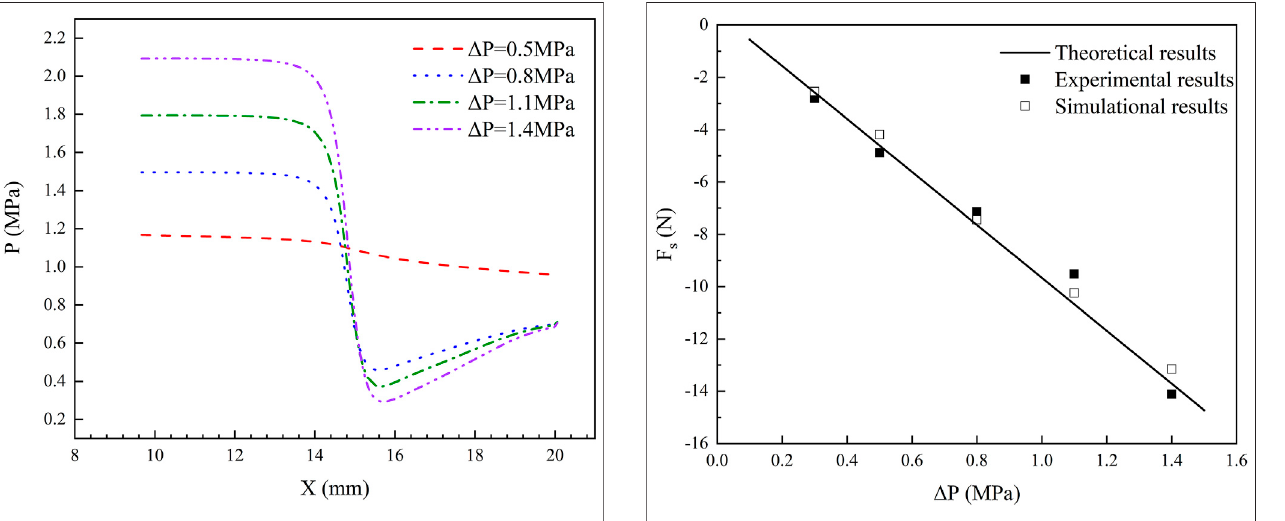
FIGURE 10 | The relationship between the differential pressure and steady-state fl ow force under various differential pressure